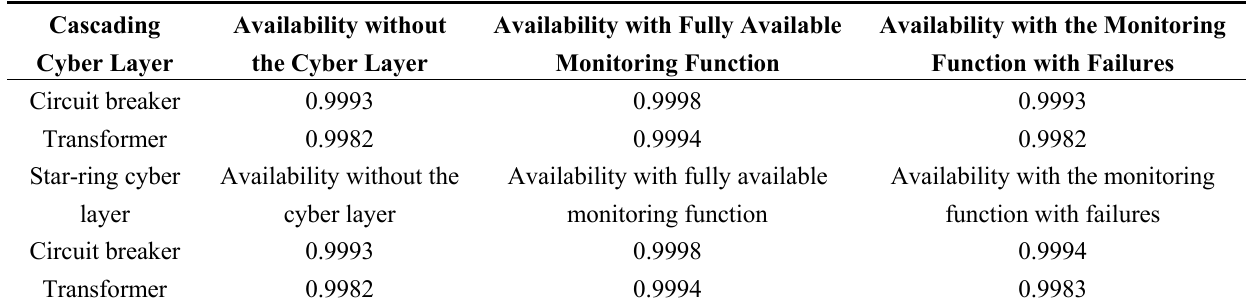
Table 4. The availability of circuit breakers and transformers incorporating the monitoring function.